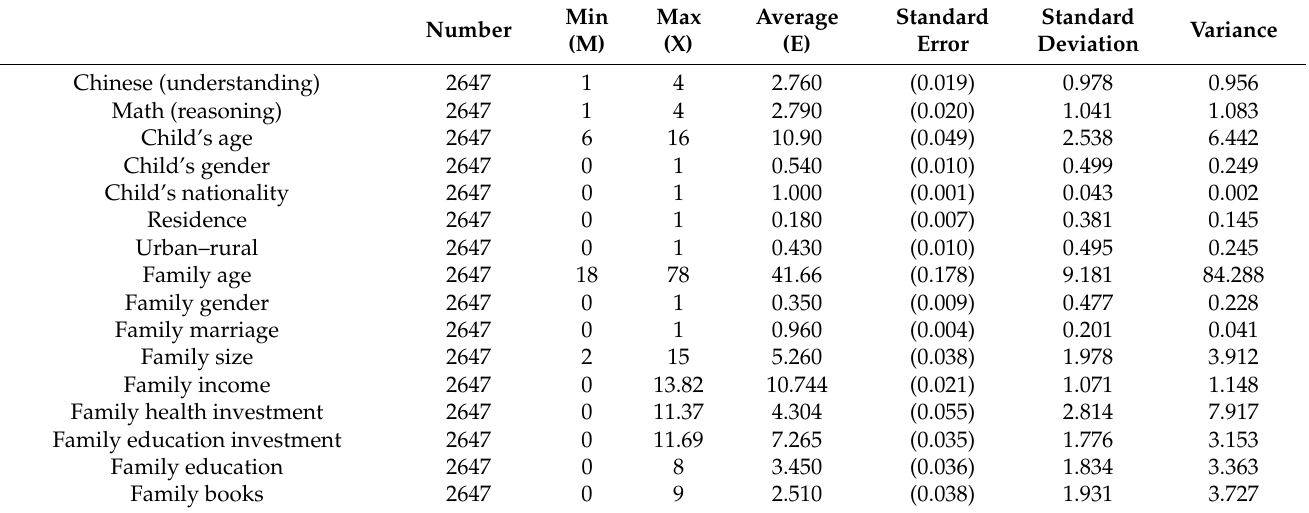
Table 1. Summary statistics of